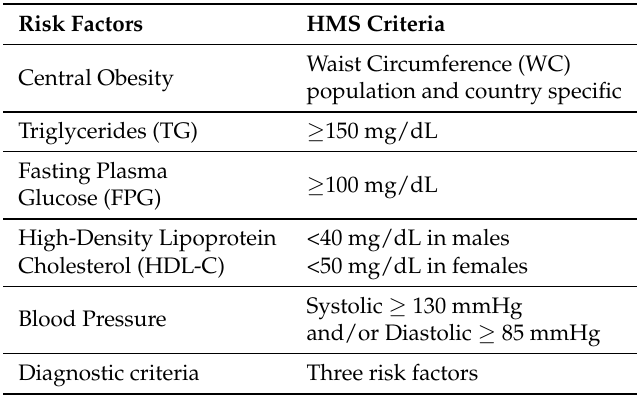
Table 1. Definition of the MetS according to HMS (Data from